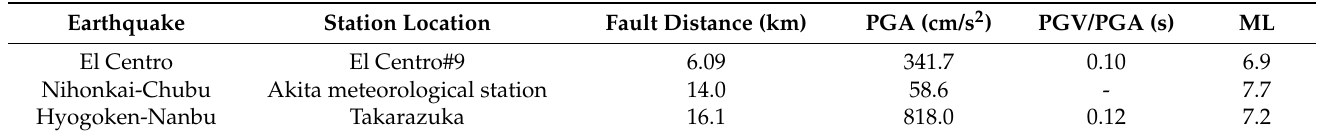
Table 4. The characteristics of different earthquake